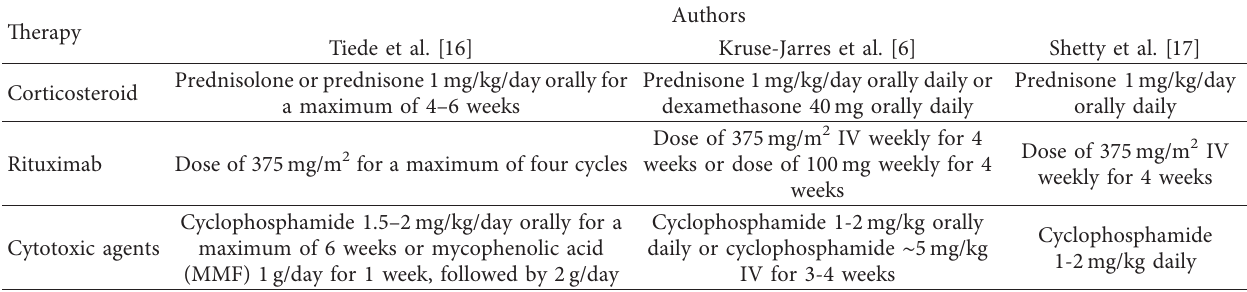
Table 2: Summary of recommended inhibitor eradication therapies found in the